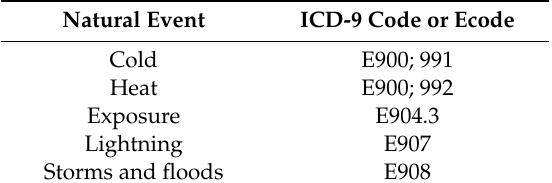
Table 2. Emergency codes (Ecodes) and ICD-9 codes used to create injury sub-categories related to natural or environmental causes.